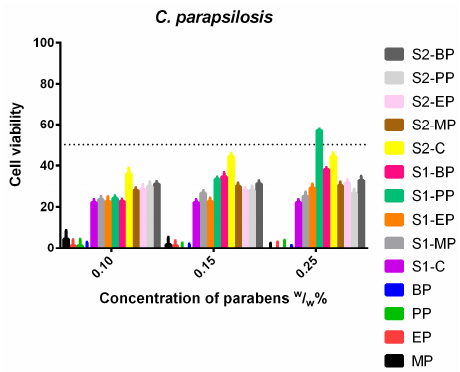
Figure 9. Cell viability of C. parapsilosis against the control paraben solutions (MP; EP; PP; BP); the first system (S1-MP; S1-EP; S1-PP; S1-BP) and the second system (S2-MP; S2-EP; S2-PP; S2-BP). Cell viability expressed as the percentage of the absorbance of the untreated control. Data expressed as mean ±